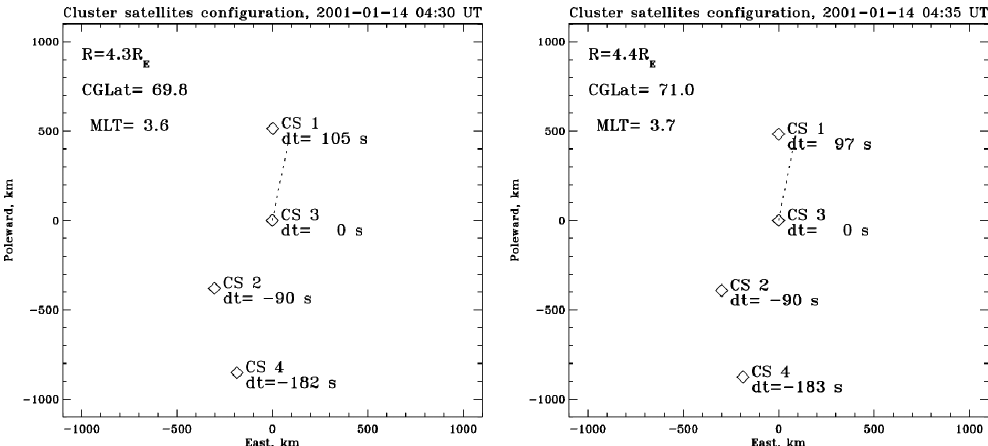
Figure 6. Fig. 6. Relative positions of the four Cluster spacecraft in a plane perpendicular to B at 04:30 and 04:35 UT on 14 January 2001. Vertical and horizontal axes represent distances in the geomagnetic poleward and eastward directions. Spacecraft 3 is located at the center. The time differences ( dt ) between the four spacecraft to that of spacecraft 3 are indicated at the spacecraft positions. The geocentric distance, corrected geomagnetic latitude and magnetic local time for spacecraft 3 are given at the top, left. The dotted line indicates the direction of the velocity component perpendicular to B for spacecraft